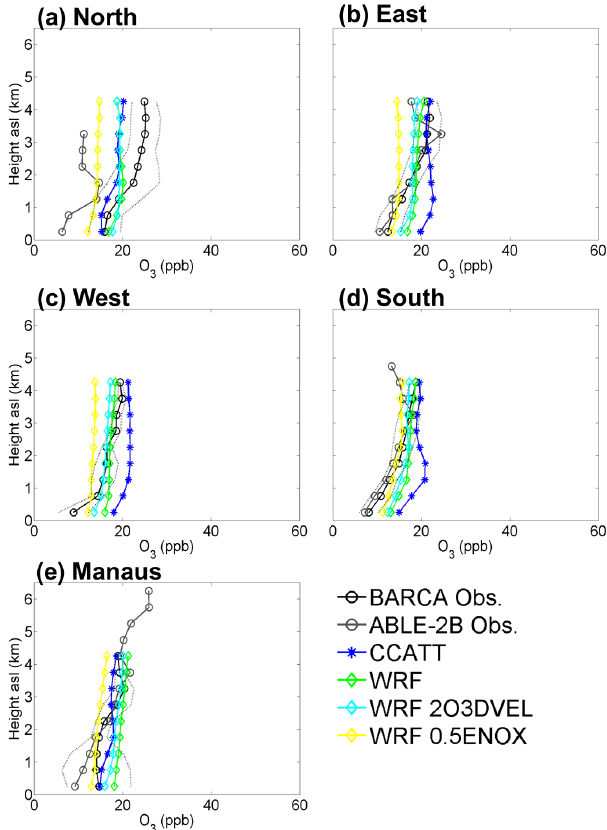
Figure 14. Mean vertical O 3 profiles for BARCA B flights for ob- servations (black, gray line denotes 1 standard deviation), CCATT- BRAMS (blue), and WRF-Chem (base case: green, 2DEPVEL: cyan, and 0.5ENO x : yellow) simulations by region: (a) north, (b) east, (c) west, (d) south, and (e) around Manaus. ABLE-2A observations (gray) from the same regions are included for com-